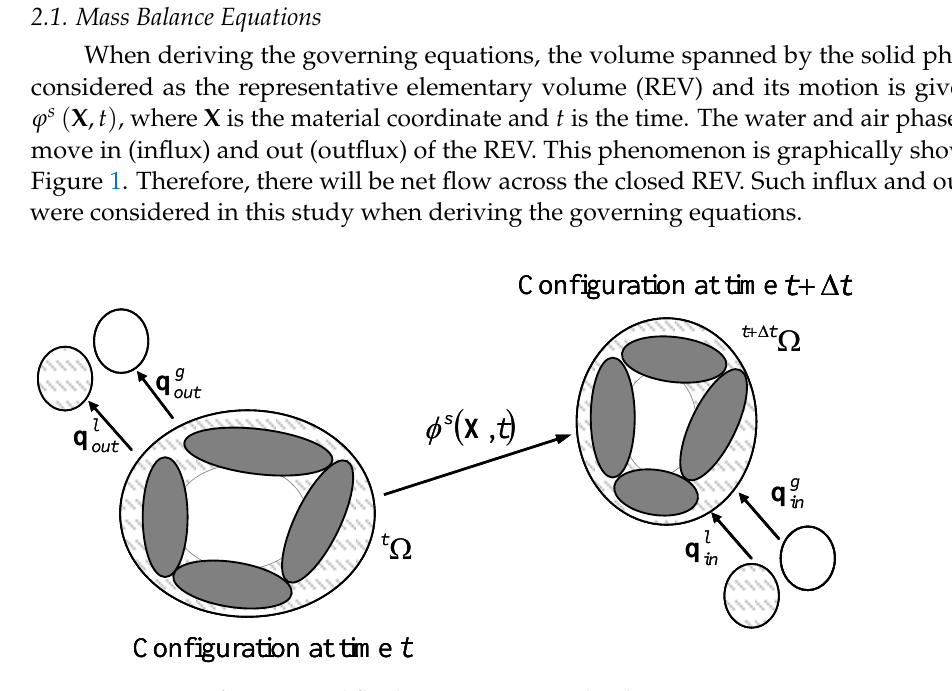
Figure 1. Motion of an REV and fluids in an unsaturated soil system. The balance of mass in an REV for a bulk phase α is given by Equation